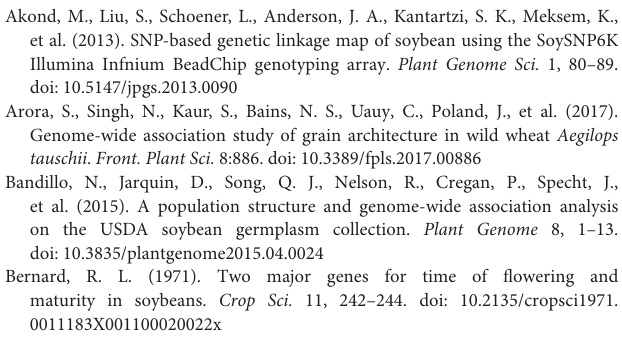
Harbin in 2011; (d) Harbin in 2012; (e) Mudanjiang in 2011; (F) Mudanjiang in 2012. Figure S4 | GWAS of flowering time (R1) in the southern geographic region using FarmCPU. Manhattan plots (bottom) and Quantile-quantile (upper right) plot for a trait. Negative log10 P -values from a genome-wide scan are plotted against SNP positions of 20 chromosomes. The horizontal dash line indicates the significant threshold (2 × 10 − 5 ). (a) Jinan in 2011; (b) Jinan in 2012; (c) Huaian in 2011; (d) Huaian in 2012; (e) Nanjing in 2011; (f) Nanjing in 2012. Figure S5 | GWAS of beginning maturity, R7, flowering time (R1) using FarmCPU. Manhattan plots (left) and Quantile-quantile (right) plot. Negative log10 P -values from a genome-wide scan are plotted against SNP positions of 20 chromosomes. The horizontal dash line indicates the significant threshold (2 × 10 − 5 ). (a) Gongzhuling in 2011; (b) Gongzhuling in 2012; (c) Mudanjiang 2011; (d) Mudanjiang in 2012; (e) Jinan in 2011; (f) Huaian in 2011; (g) Huaian in 2012; (h) Nanjing in 2011; (i) Nanjing in 2012. Figure S6 | GWAS of full maturity, R8, using FarmCPU. Manhattan plots (left) and Quantile-quantile (right) plot. Negative log10 P -values from a genome-wide scan are plotted against SNP positions of 20 chromosomes. The horizontal dash line indicates the significant threshold (2 × 10 − 5 ). (a) Gongzhuling in 2011; (b) Gongzhuling in 2012; (c) Mudanjiang 2011; (d) Mudanjiang in 2012; (e) Jinan in 2011; (f) Huaian in 2011. Figure S7 | GWAS of oil contents using FarmCPU. Manhattan plots (left) and Quantile-quantile (right) plot. Negative log10 P -values from a genome-wide scan are plotted against SNP positions of 20 chromosomes. The horizontal dash line indicates the significant threshold (2 × 10 − 5 ). (a) Harbin in 2011; (b) Harbin in 2012; (c) Mudanjiang 2011; (d) Mudanjiang in 2012; (e) Jinan in 2011; (F) Jinan in 2012; (g) Huaian in 2011; (h) Huaian in 2012; (i) Nanjing in 2011. Figure S8 | GWAS of protein contents using FarmCPU. Manhattan plots (left) and Quantile-quantile (right) plot. Negative log10 P -values from a genome-wide scan are plotted against SNP positions of 20 chromosomes. The horizontal dash line indicates the significant threshold (2 × 10 − 5 ). (a) Harbin in 2011; (b) Harbin in 2012; (c) Mudanjiang 2011; (d) Mudanjiang in 2012; (e) Jinan in 2011; (F) Jinan in 2012; (g) Huaian in 2011; (h) Huaian in 2012; (i) Nanjing in 2011. Table S1 | Geographic origins of soybean cultivars or accession used in this study. Table S2 | The correlation coefficients between R1 (first flower), R7 (beginning of maturity) and R8 (Fully Maturity) of soybean cultivars grown at different locations in 2011 or 2012. Table S3 | QTNs for flowering time (R1) and maturity (R7 or R8) were detected using FarmCPU. Table S4 | QTNs for protein and oil contents were detected using